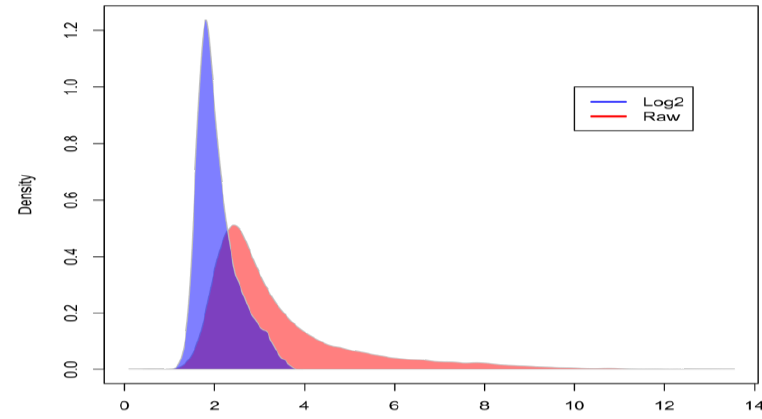
Figure 4. Density plot of RNA-seq data before (red) and after (blue) power transformation (mean = 3.44, SD = 1.701 and mean = 2.069, SD = 0.4604, respectively).